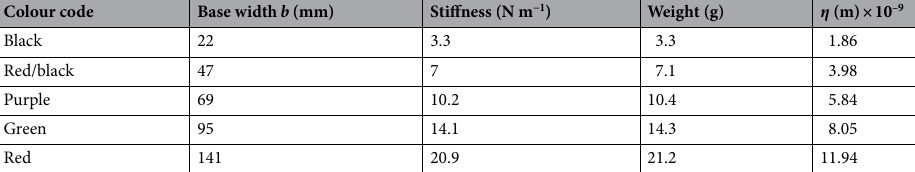
Colour code Base width b (mm) Stiffness (N m −1